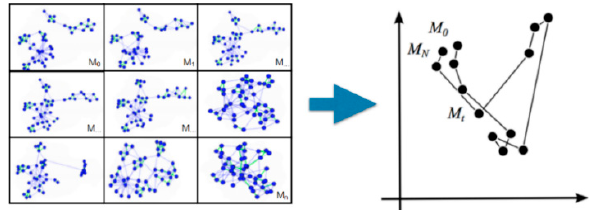
Figure 27. Dimensionality-reduction process that transforms the snapshot on the left into two-